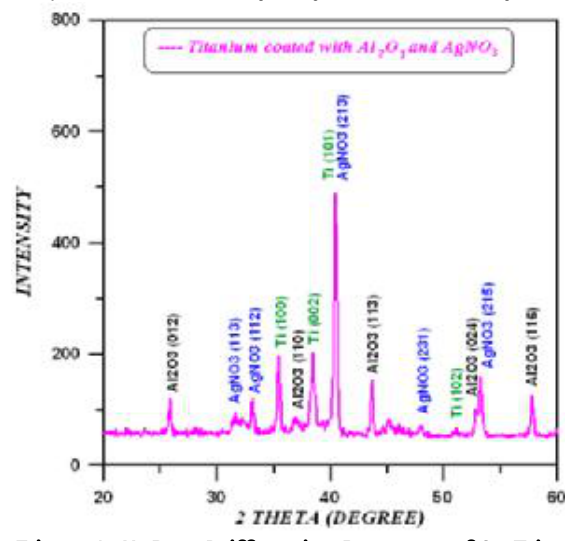
O and AgNo . 2 3 3